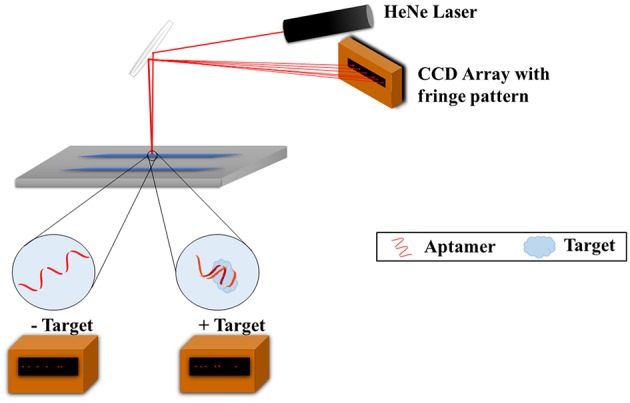
Backscattering interferometry setup for aptamer-target binding measurements. The target and aptamer are incubated together in a microfluidic channel. A helium-nexon laser irradiates the sample and the beam is reflected and refracted within the channel. The laser exits as a fringe pattern and is detected with the CCD array. Binding of the aptamer to the target changes the refractive index of the laser and subsequently the fringe pattern, and as such binding can be studied.